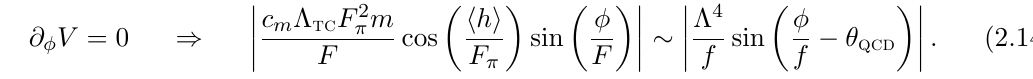
Figure 2 . Sketch plot of the e(cid:11)ects of post-in(cid:13)ation slope-drop for the cases of (cid:13) i 1 (left column) (cid:24) and (cid:13) i 10 10 (right column); the top row shows the potentials during in(cid:13)ation ( (cid:13) = (cid:13) i ), while the (cid:24) bottom row shows the situation after slope drop ( (cid:13) 0). In all panels, the solid, thick (black) curve ! shows the total (cid:30) potential with h pinned to its minimum, with the open (black) circle showing where the relaxion stalls rolling before slope-drop (i.e., with (cid:13) = (cid:13) i ), and the solid (black) circle (bottom row only) showing where the relaxion would settle after slope-drop ( (cid:13) = 0). The (green) arrows (bottom row only) indicate how the relaxion rolls from its initial stalling position to the position it assumes once the scanning slope drops. The long-dashed (green) line (top row only) shows the contribution to the total potential from the ‘scanning potential’ before slope drop (i.e., with (cid:13) = (cid:13) i ), the medium-dashed (red) line shows the contribution from the strong dynamics, and the short-dashed (blue) line shows the QCD contribution. In order to display all the individual potential contributions on the same axes, the zero-point of each individual contribution to the potential has been independently shifted so that all the contributions cross at the point where the relaxion stalls [i.e., the three dashed (colored) lines sum up to the solid (black) line plus a constant o(cid:11)set], such that the important slope information from each contribution at that point is clearly visible. The vertical line marked (cid:18) e(cid:11). qcd = 0 is the point where the e(cid:11)ective QCD (cid:18) -angle would vanish in the dip in the periodic QCD potential just prior to the initial relaxion stalling point. The estimate for the post-in(cid:13)ation settling point for the relaxion is obtained from eqs. (2.3), (2.4) and (2.10) with (cid:13) 0: !